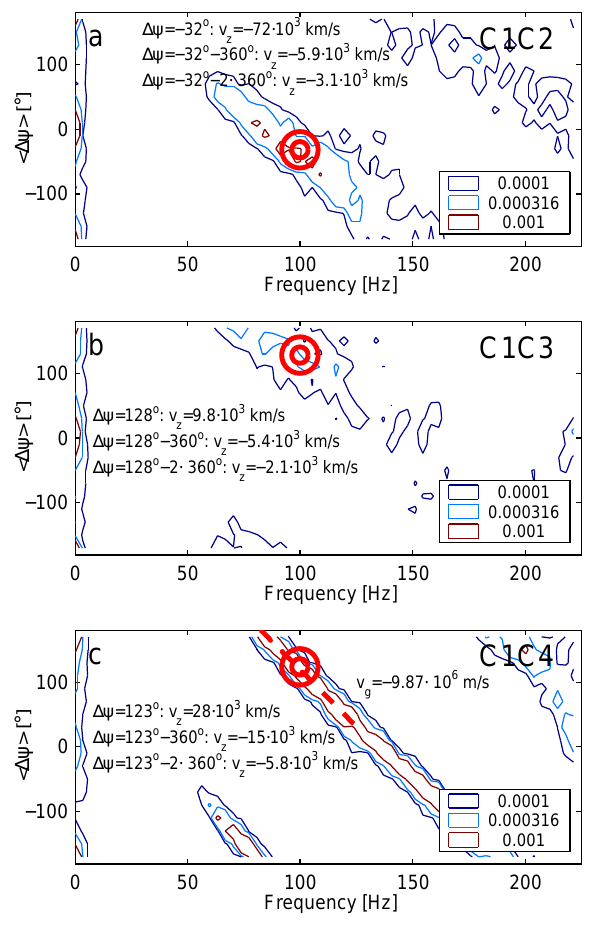
Fig. 7. The contours show the distribution of cross spectral den- sity, S BxBx 0 , in frequency, f , and averaged phase difference, h 1ψ i (= η xy ). Data used are from the STAFF experiment. The cross spectral density is in units of (nT) 2 / ◦ Hz. We have used a record length of 256 points and have averaged over 101 time records and two frequencies. The total time interval used is 60s, starting from 03:29:00 UT. The top panel shows the result from correlating sig- nals from C1 and C2, the middle panel displays the result from cor- relating C1 and C3, and the bottom panel is produced correlating C1 and C4. The coherences in the frequency range of interest are about 0.5, 0.5 and 0.9, respectively. The phase velocity, v z , is estimated at 100Hz. A few possible values of v z , assuming a different number of multiples of 2 π , are indicated in each panel. All spacecraft pairs agree for a phase velocity of about 5.4–5.9 · 10 3 km/s anti-parallel to B 0 . The group velocity is determined only for the C1/C4 case. It is inversely proportional to the slope of a straight line fitted to the results and the estimate yield about 10000km/s.